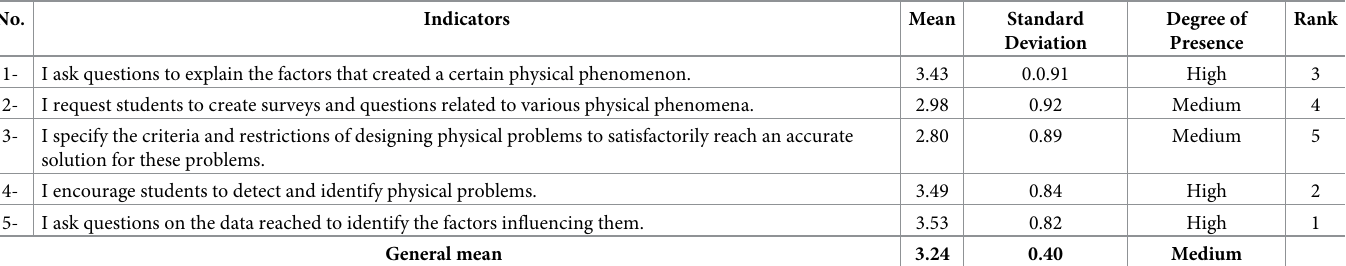
Table 2. The means and deviations of the presence of the “asking questions and defining problems” practice. No.